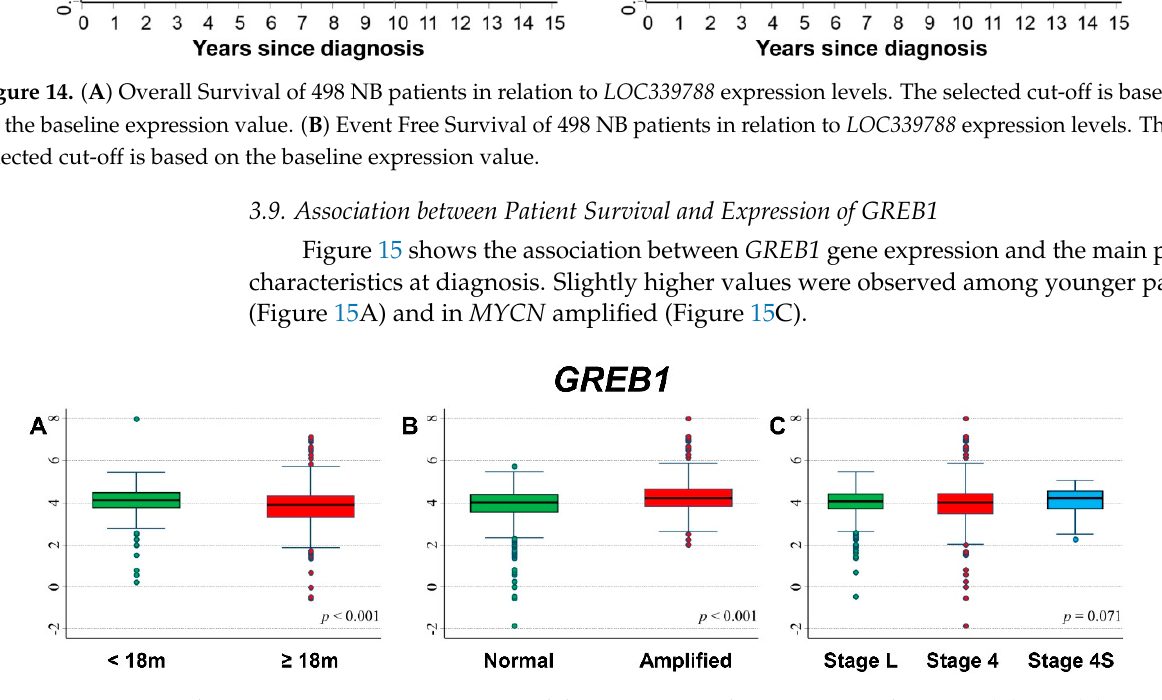
Figure 15. Association between GREB1 gene expression and the main patient characteristics at diagnosis. ( A ) Age; ( B ) MYCN status; ( C )